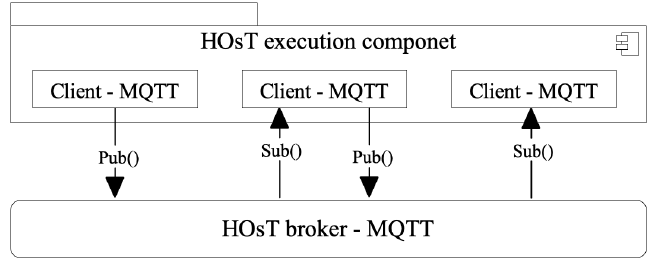
Figure 3. Pub/Sub communication